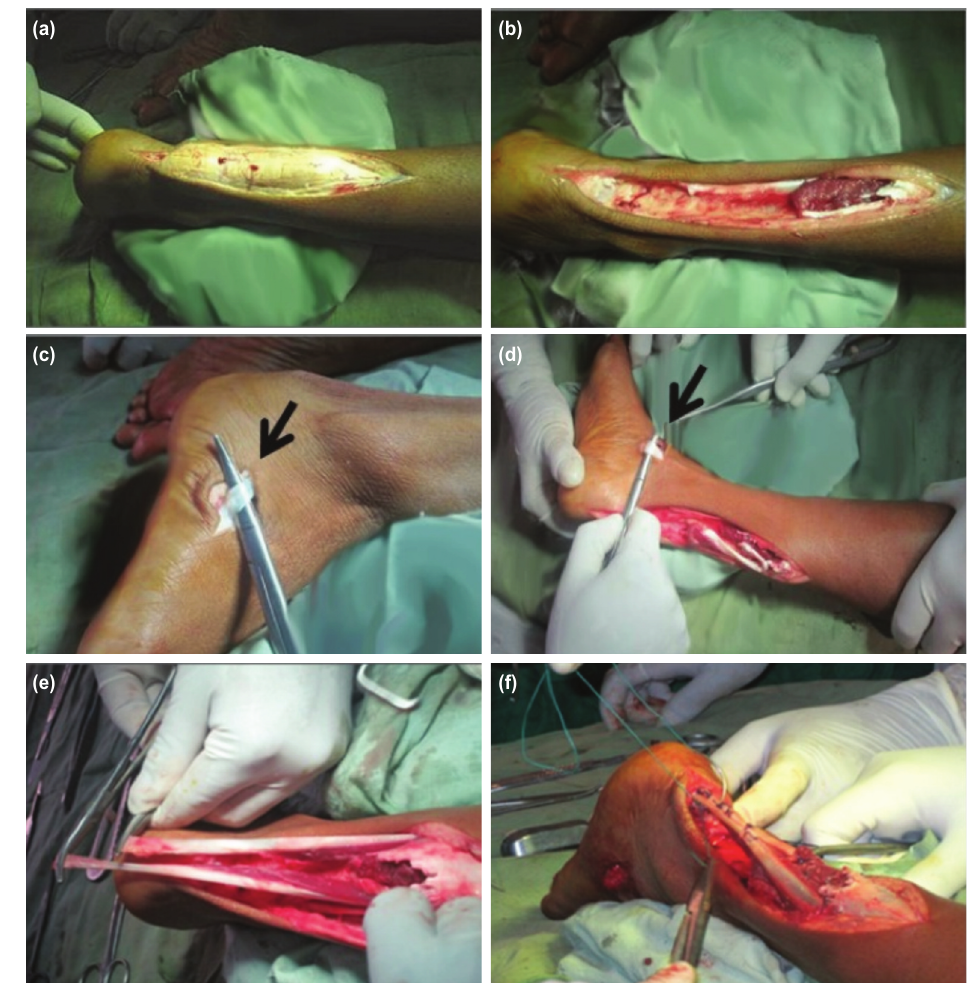
(a) Intra-operative photograph showing incision over the posterior aspect of the right AT. Note that the tendon was enlarged Fig. 2: as a yellow-orange-red firm swelling. (b) Abnormal AT tendons were excised almost completely creating a large gap. (c) Incision over the base of fifth metatarsal enabling identification of the distal end of the peroneus brevis tendon. (d) The posterior tibial tendon was identified in the medial side and under the medial malleolus. (e) The peroneus brevis and posterior tibial tendon being delivered into the wound and approximated. (f) Both tendon ends after sutured with nonabsorbable, braided sutures and were fixed after tunnelled through a drill hole through the dorsal aspect of